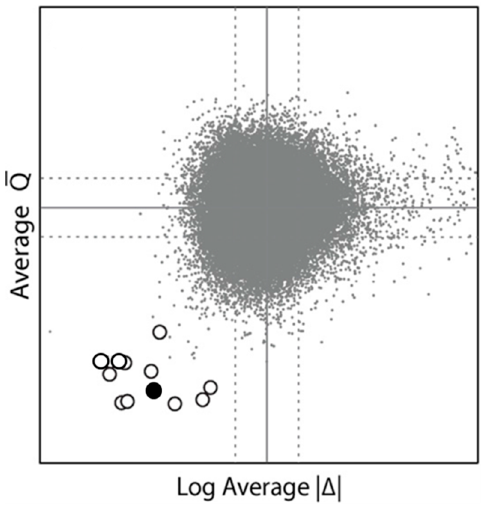
Figure 7. Plot of Q versus | ∆ | of X-ray diffraction patterns listed in the ICDD-PDF. The main cluster of grey dots corresponds to crystalline materials and the open circles correspond to the known synthetic quasicrystals with icosahedral symmetry. The black circle represents the new mineral icosahedrite, whose Q and | ∆ | values are within the cluster of quasicrystals. Reproduced with permission from Bindi [54].